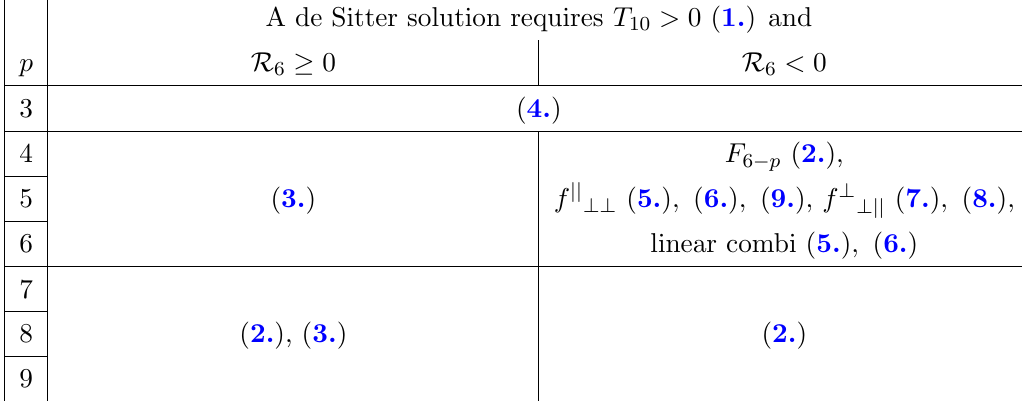
Table 1 . Most of the constraints known on the existence of type II supergravity de Sitter solutions with parallel D p =O p sources (with single size p ). Few more constraints, and an analogous table for intersecting sources, can be found in [24]. An empty cell implies the absence of de Sitter solutions, while an entry ((cid:13)ux, etc., de(cid:12)ned in section 2.2) means that it is a necessary ingredient to get a de Sitter solution. The ( number. ) refer to the no-go theorems, discussed in this paper, that prove the absence of solution or the need of some ingredient and constraints on